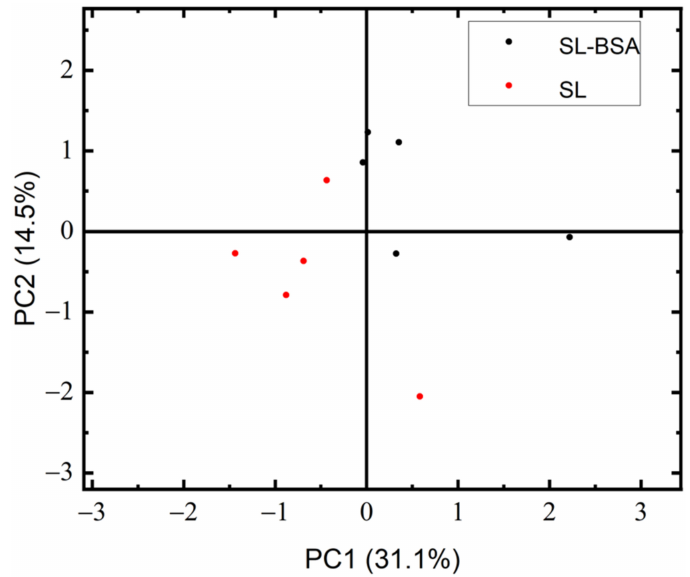
Figure 11. Principal component analysis (PCA) of the collected spectra for SL and SL-BSA. Red dots represent SL. Black dots represent